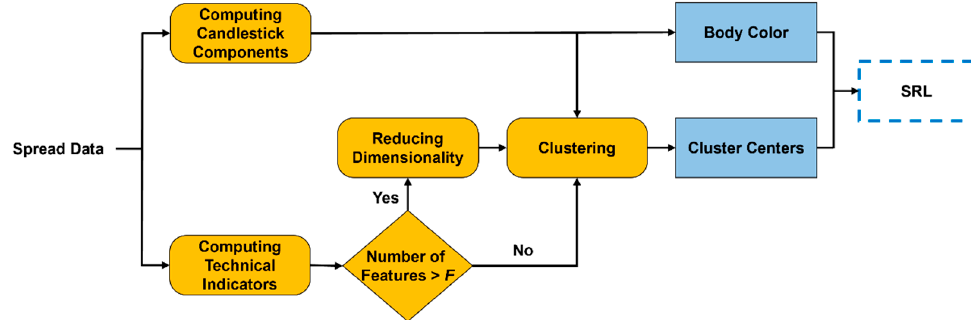
Figure 4. Data preprocessing. Table 1. Input features.